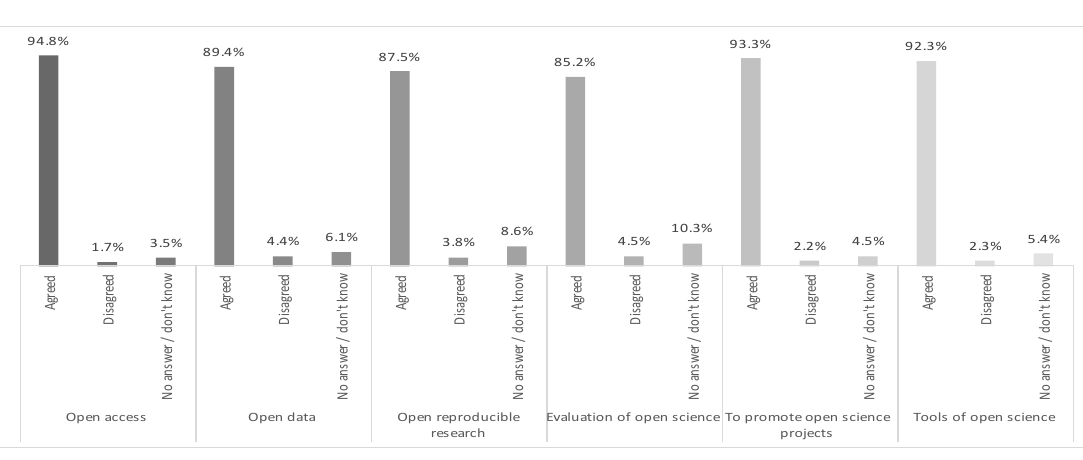
Figure 7. Elements that should be included in an open science policy in Colombia, according to Colombian researchers.